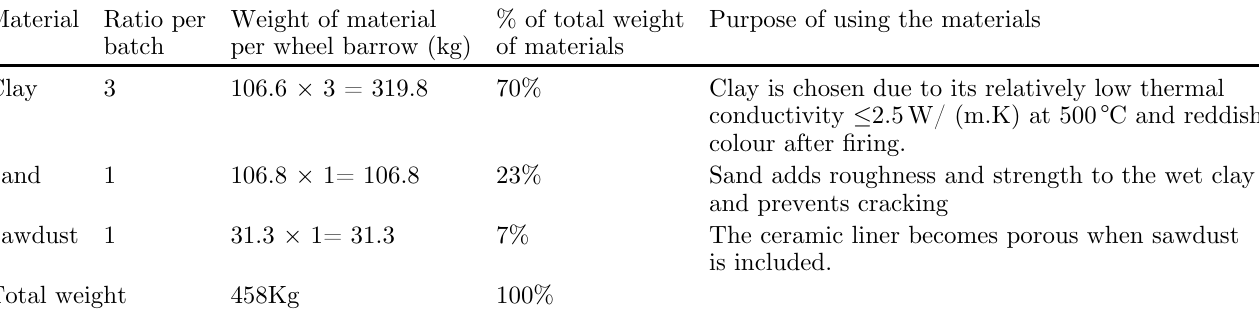
Table 1. Material composition and purpose of using the materials. Material Ratio